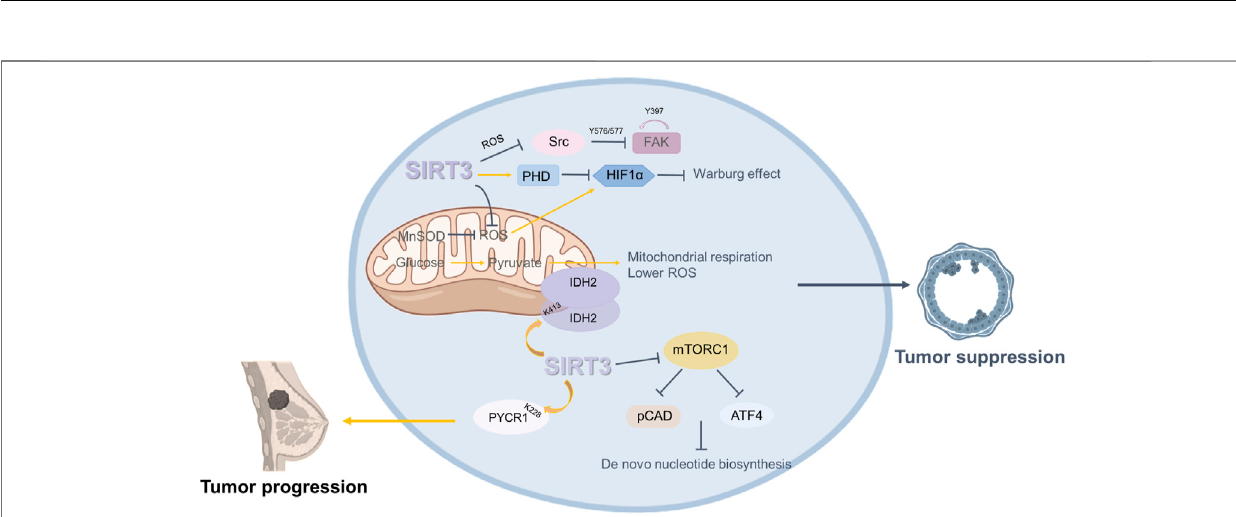
FIGURE 4 | Roles of SIRT3 in breast cancer. SIRT3 plays a dual role in breast cancer. On the one hand, SIRT3 plays an oncogenic role in breast cancer. SIRT3 regulates the progression and metabolism of breast cancer cells by mediating IDH2 dimerization. SIRT3 deacetylates PYCR1 at the K228 site to modulate proline metabolism and promote the growth of MCF-7 cells. On the other hand, some studies have shown that SIRT3 plays a role in suppressing breast cancer. SIRT3 restricts breast cancer cell. Loss of SIRT3 promotes ROS production and mediates an enhanced breast tumor phenotype.